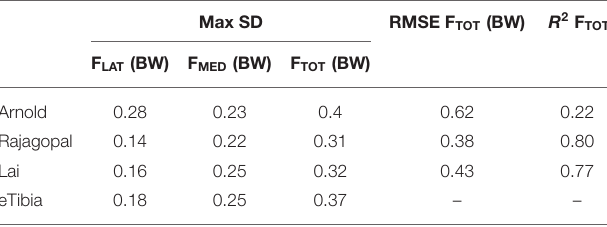
Root mean squared error (RMSE) and coefficient of determination (R 2 ) are computed for the results of three models considering the total contact force acting at the tibial insert